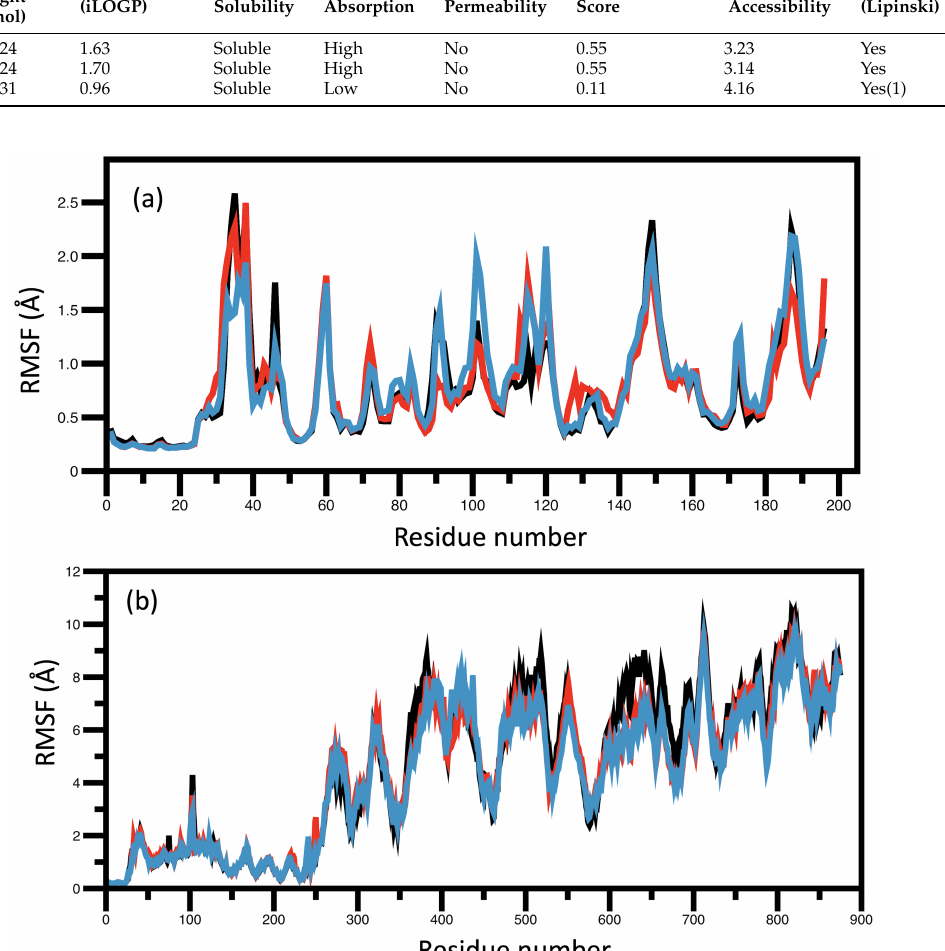
Figure 7. RMSF analysis for NS3 and NS5 receptors. ( a ) RMSF-NS3, ( b ) RMSF-NS5 by black—Quercetin, red—Kaempferol, and blue—Chlorogenic